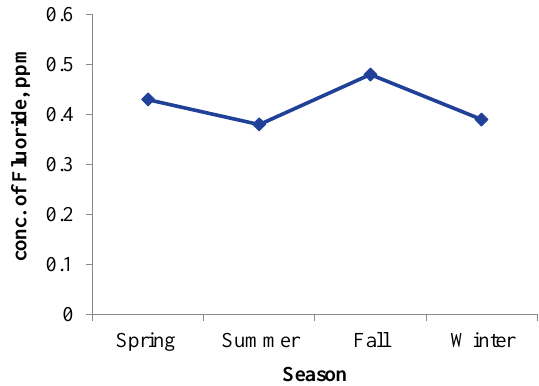
Figure 3. The average concentration of fluoride by season 2008-2013